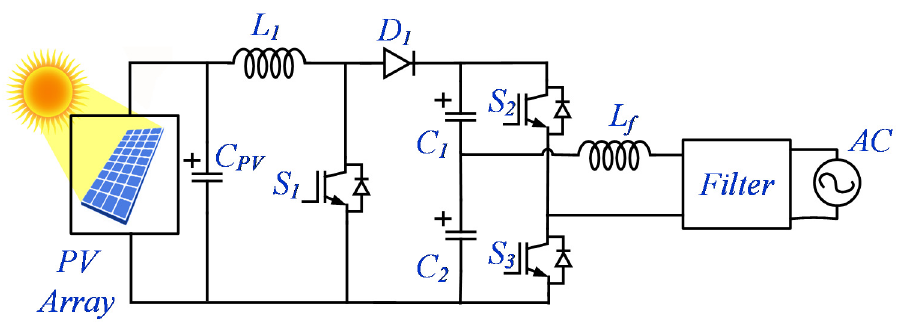
Figure 9. Soft switched parallel resonant boost converter and full-bridge inverter .